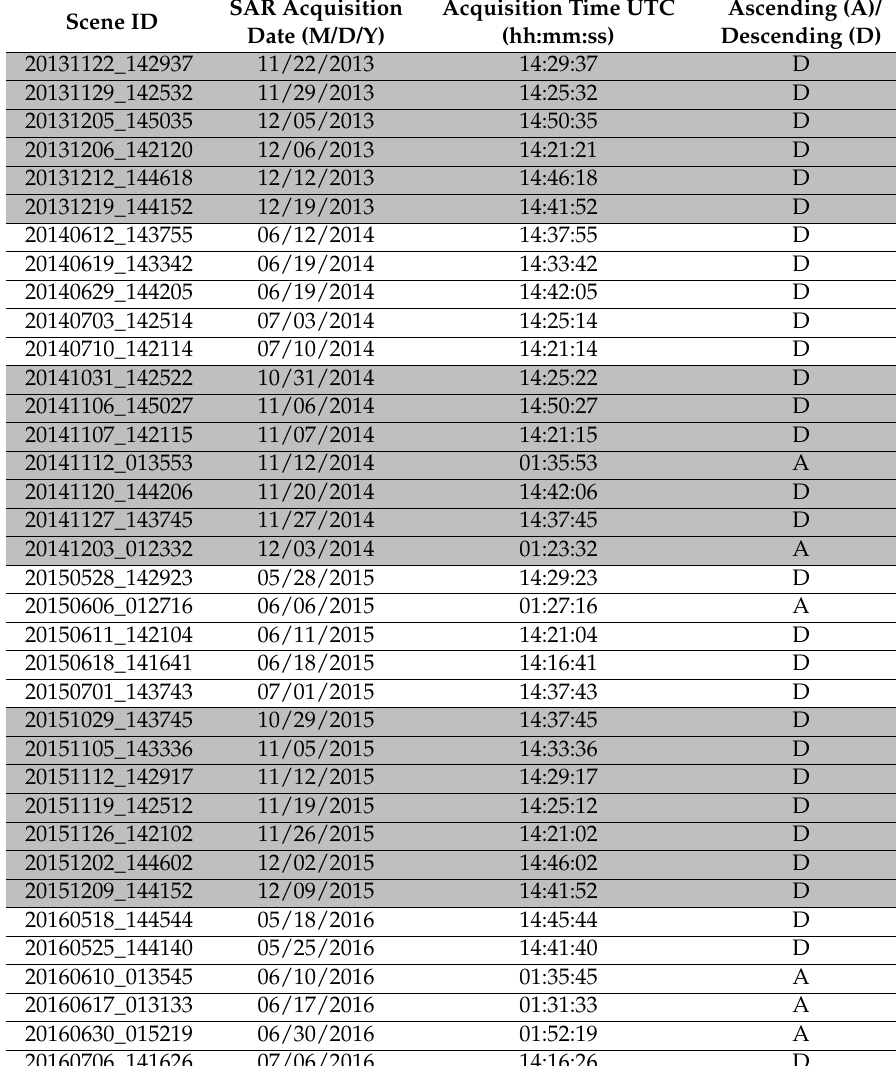
Table 1. List of SAR scenes used in this work. Highlighted scenes indicate ice freeze-up period while non-highlighted indicate ice break-up